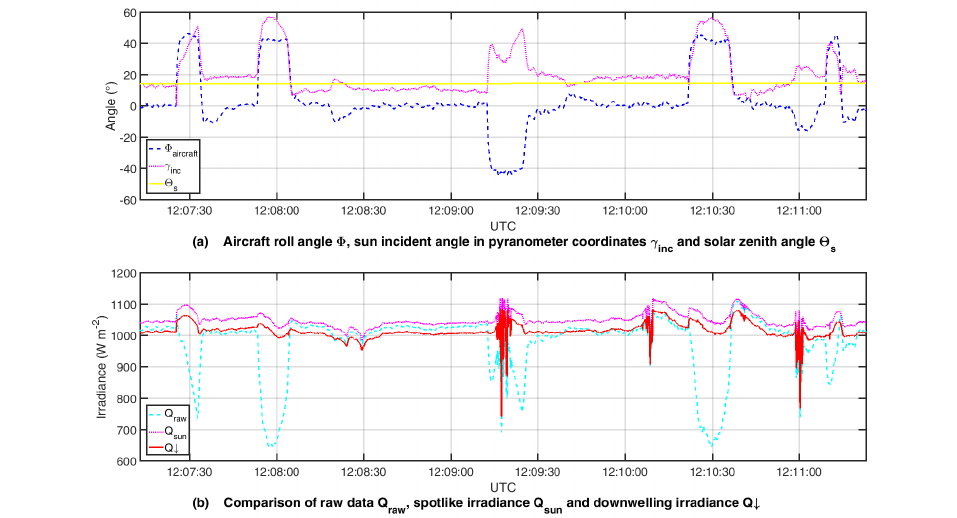
Figure 13. Correction of the sun incident angle on the upward looking pyranometer sensor and shortwave downwelling irradiance, raw data measured on 11 July at 12:10 UTC in Savè (Collines, Benin) during the project DACCIWA